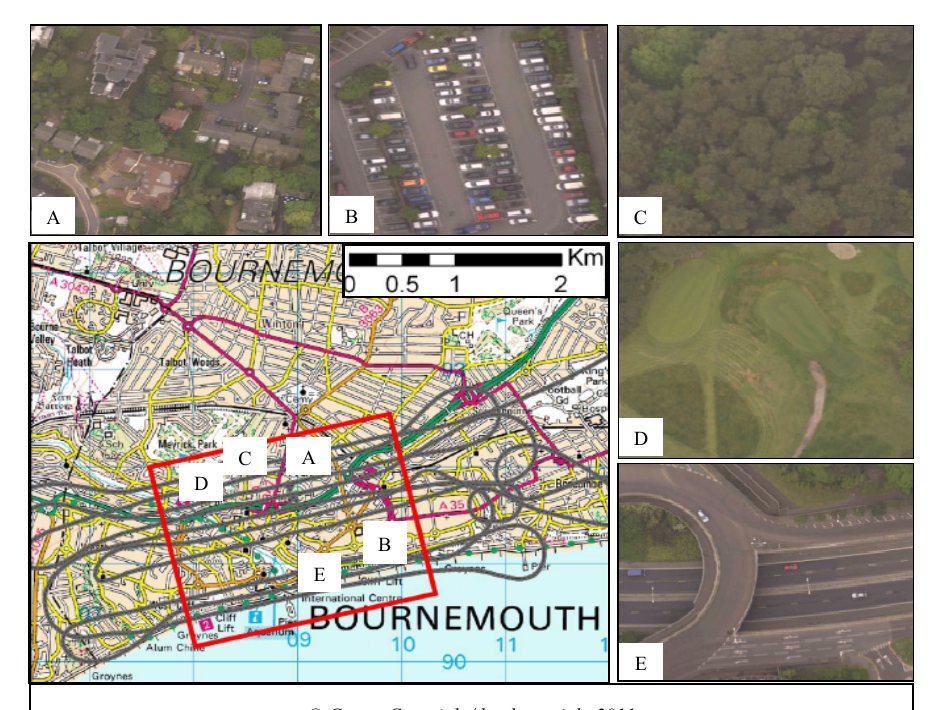
Figure 1. Study site, with red polygon defining the ground coverage and trajectory depicted in grey. Sample land-cover features are detailed in orthophotos A to E, and described further in Section